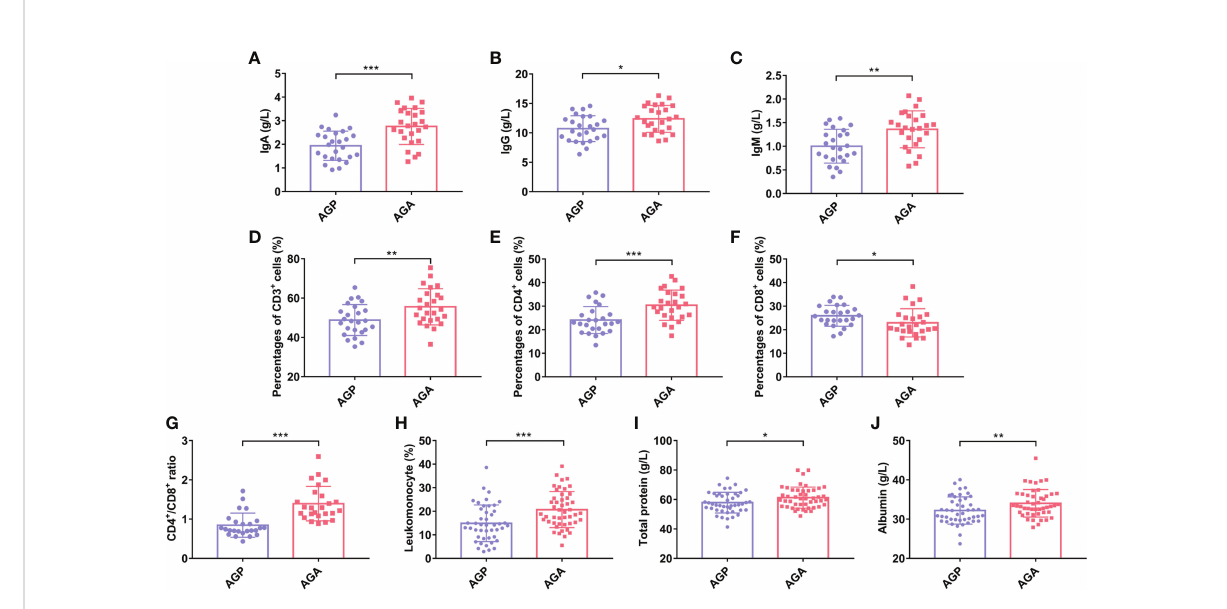
FIGURE 3 C butyricum enhanced immunity and relieved hypoalbuminemia in patients with gastric cancer after gastrectomy. (A) IgA; (B) IgG; (C) IgM; (D) Percentages of CD3 + T cell; (E) Percentages of CD4 + T cell; (F) Percentages of CD8 + T cell; (G) CD4 + T/CD8 + T ratio; (H) Percentage of Lymphocyte; (I) Total protein; (J) Albumin. AGP, gastric cancer patients and treatment with the placebo after gastrectomy (n=45); AGA, gastric cancer patients and treatment with the C butyricum after gastrectomy (n=47). Data are presented as means ± SD. * P < 0.05, ** P < 0.01, *** P < 0.001. Ig,